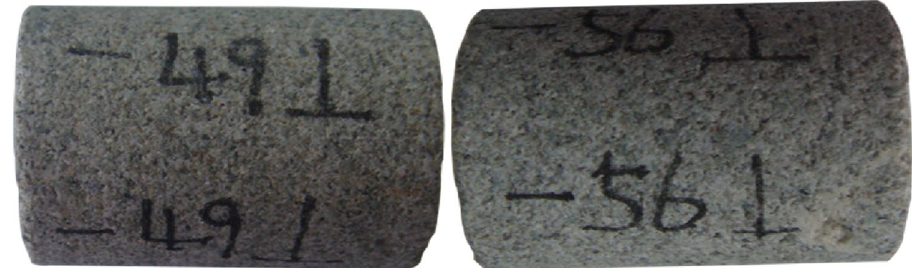
Fig. 1 Physical photos of No. 1 and No.2 rock samples from wellY bei X